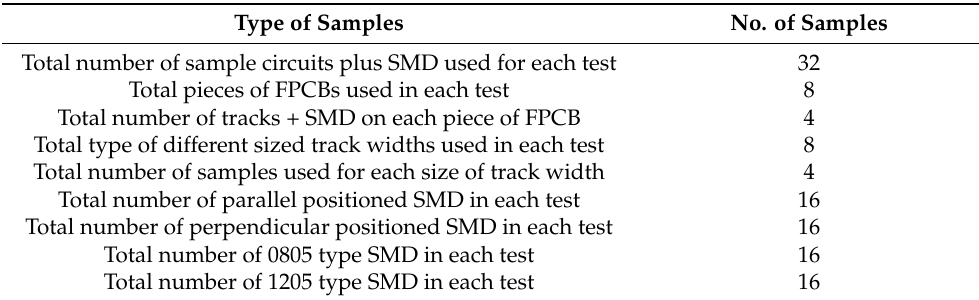
Table 1. Details of samples used for each type of test.